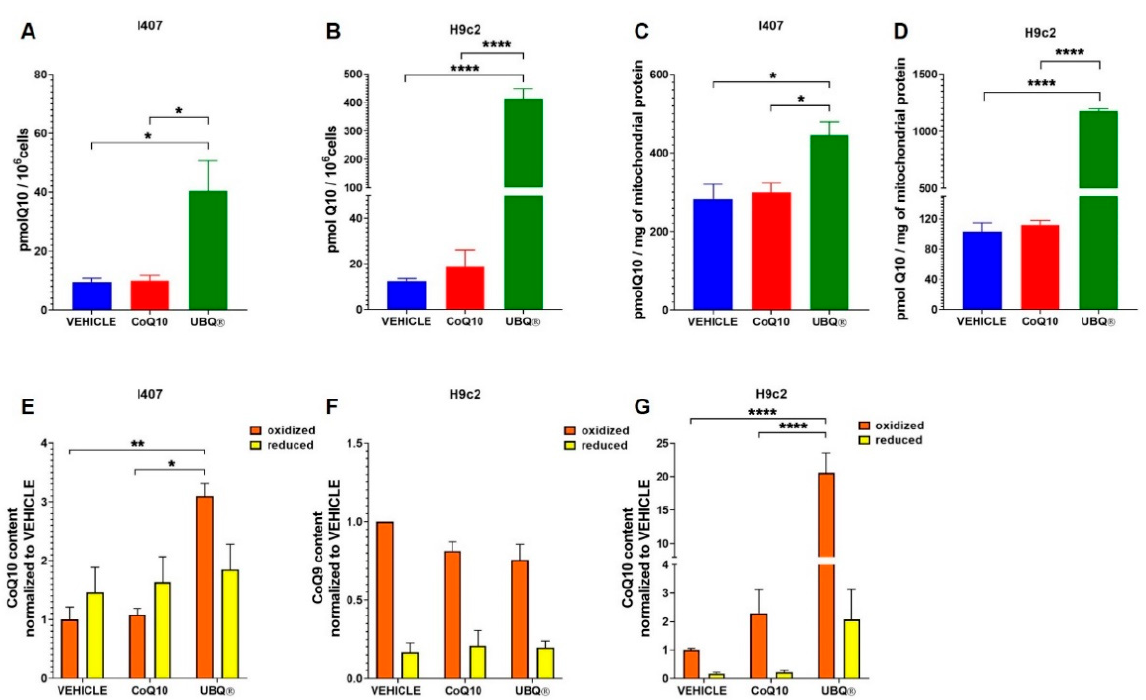
Figure 1. Coenzyme Q10 determination in different cell lines after products incubation. Total CoQ10 content in I407 cells ( A ) and H9c2 cells ( B ) treated for 24 h with 100 nM of CoQ10 phytosome (UBQ), 100 nM of native CoQ10 (Q10) and phytosome (Vehicle) ( n = 3). Mitochondrial CoQ10 content in I407 cells ( C ) and H9c2 cells ( D ) treated for 24 h with 100 nM UBQ, 100 nM of native Q10 and phytosome (Vehicle) ( n = 3). Data were normalized to mitochondrial protein content ( n = 3). ( E ) Reduced and oxidized CoQ10 content in I407 cells treated as above. Data are presented as fold increase over oxidized CoQ10 content of the vehicle-treated sample; ( n = 3). ( F ) Reduced and oxidized CoQ9 content in H9C2 cells treated as above. ( G ) Reduced and oxidized CoQ10 content in H9C2 cells treated as above. Data are presented as fold increase over oxidized CoQ9 or CoQ10 content of the vehicle-treated sample; ( n = 3). For all panels, data are presented as the mean ± s.e.m, * p ≤ 0.05; ** p ≤ 0.01; **** p ≤ 0.0001. Statistical analysis was performed using one-way ANOVA followed by Tukey’s honest significant difference test.